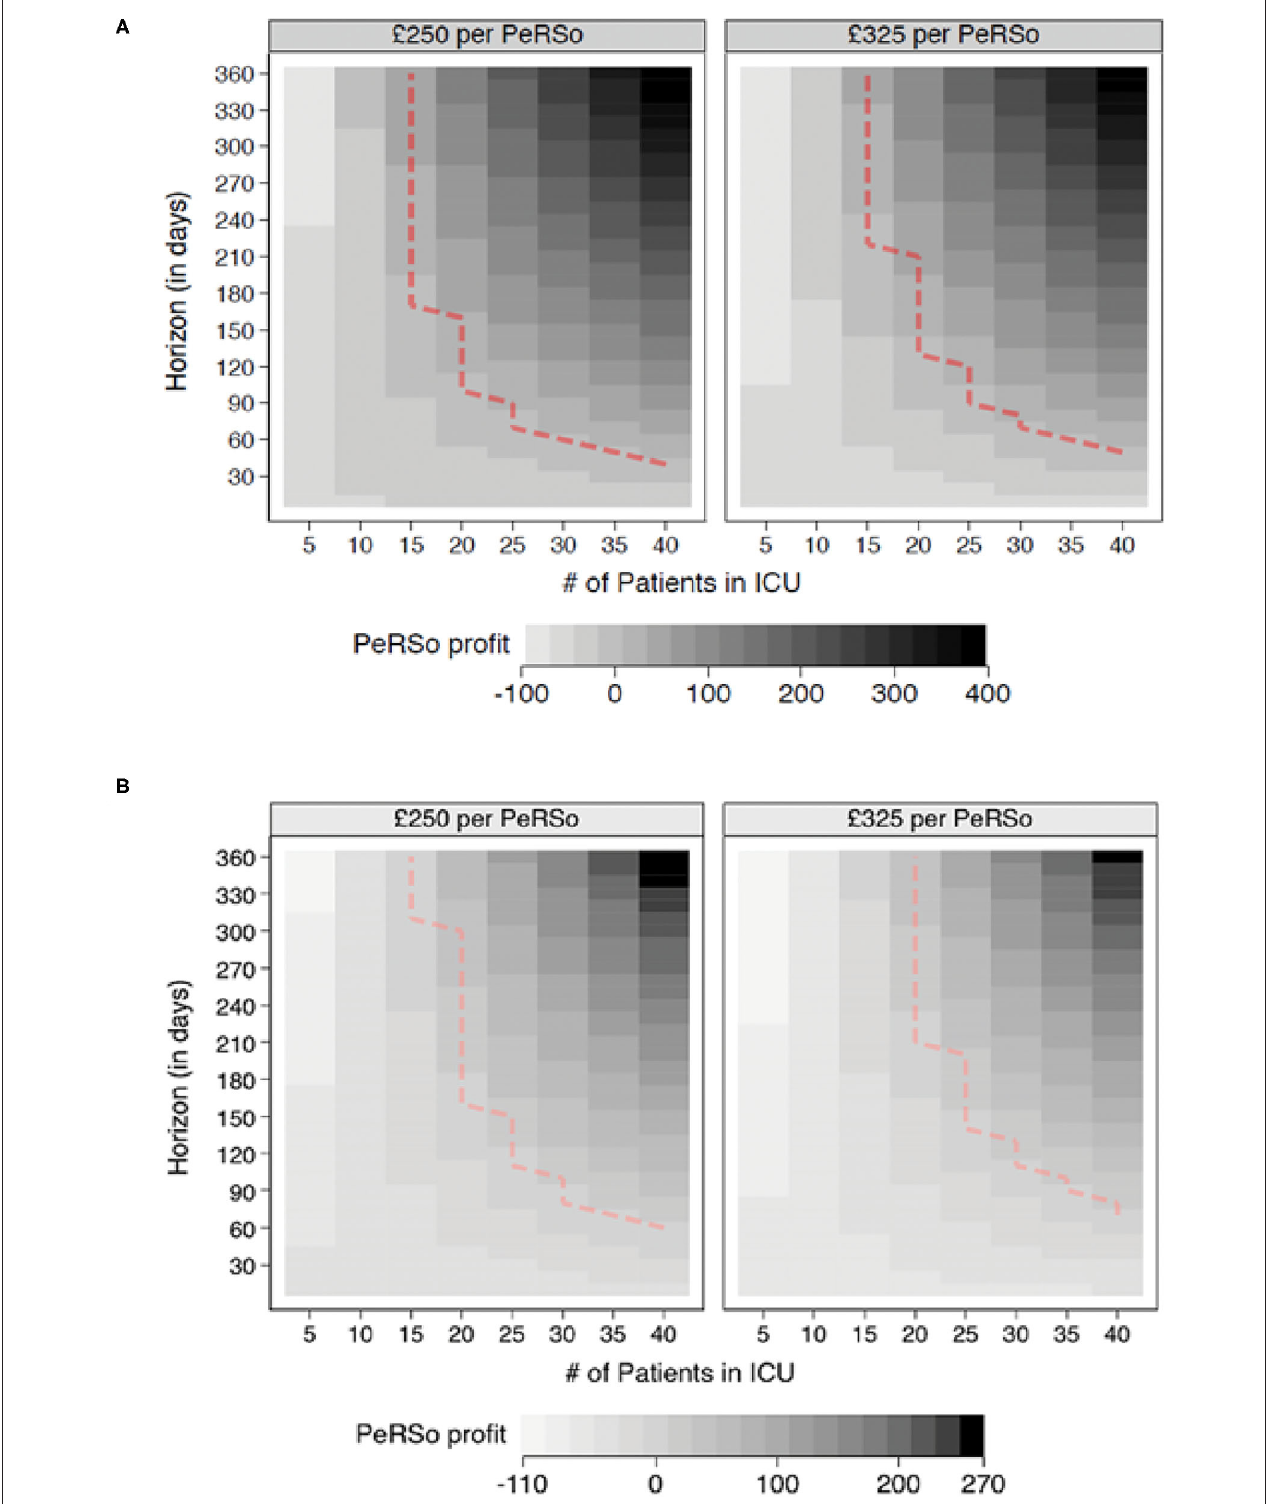
FIGURE 2 | PeRSo cost savings. (A) Comparisons between PeRSo and FFP3 facemasks. (B) Comparisons between PeRSo and a mixture of FFP3 and surgical facemasks. Positive values represent simulation outcomes where PPE costs are greater than PeRSo costs. The dashed line represents the boundary of PeRSo deployment becoming cost saving, with outcomes further to the right implying greater saving from PeRSo use.